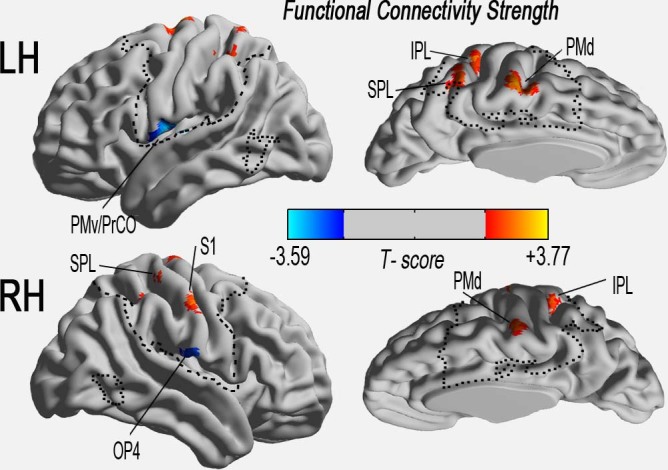
Altered functional connectivity strength (FCS) of the sensory-motor network measured by degree centrality in cervical spondylotic myelopathy (CSM) patients compared to healthy controls.Spatial distribution of significant changes in the CSM (P < 0.05, AlphaSim corrected critical cluster size was k = 20), visualised with a surface brain using Brainnet Viewer software (www.nitrc.org/projects/bnv/). The colour bars indicate the t-scores. Yellow-red and cyan-blue colours denote increased and decreased FCS in CSM patients, respectively.Note: CSM = cervical spondylotic myelopathy; FCS = functional connectivity strength; HSC = healthy subject control; IPL = inferior parietal lobule; k/k0 = normalised FCS; LH = left hemisphere; MNI = Montreal Neurological Institute; MTG = middle temporal gyrus; OP4 = operculum parietale 4; PMv = premotor ventral; PrCO = precentral operculum; PMd = premotor dorsal; RH = right hemisphere; RO = rolandic operculum; PreG = precentral gyrus; PostG = postcentral gyrus; S1 = primary somatosensory complex; SPL = superior parietal lobule; SMA = supplementary motor area. The same abbreviations were used for all of the figure and tables.